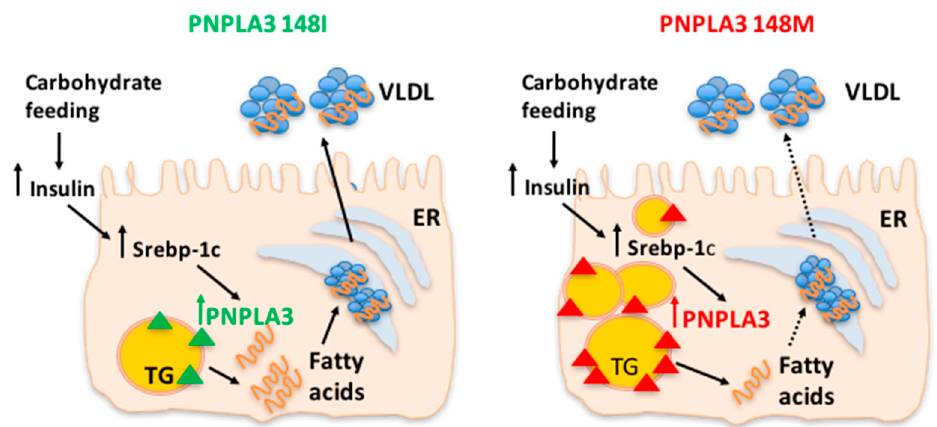
Figure 1. The patatin-like phospholipase domain-containing 3 (PNPLA3) 148M variant favors triglyceride (TG) accumulation upon carbohydrate feeding. The reduced capacity of subjects with the PNPLA3 148M/M genotype to hydrolyze TG in the liver is exacerbated by high dietary sugar intake because carbohydrate-mediated up-regulation of PNPLA3 would favor the accumulation of the pathological protein on the surface of lipid droplets. Personalized dietary intervention based on reduction of carbohydrates intake in individuals with the PNPLA3 at risk genotype may lead to more effective clinical outcomes for NAFLD patients. ER: endoplasmic reticulum; VLDL: very low-density lipoprotein. Solid lines indicate unmodified pathways, dashed lines indicate pathways which are reduced.